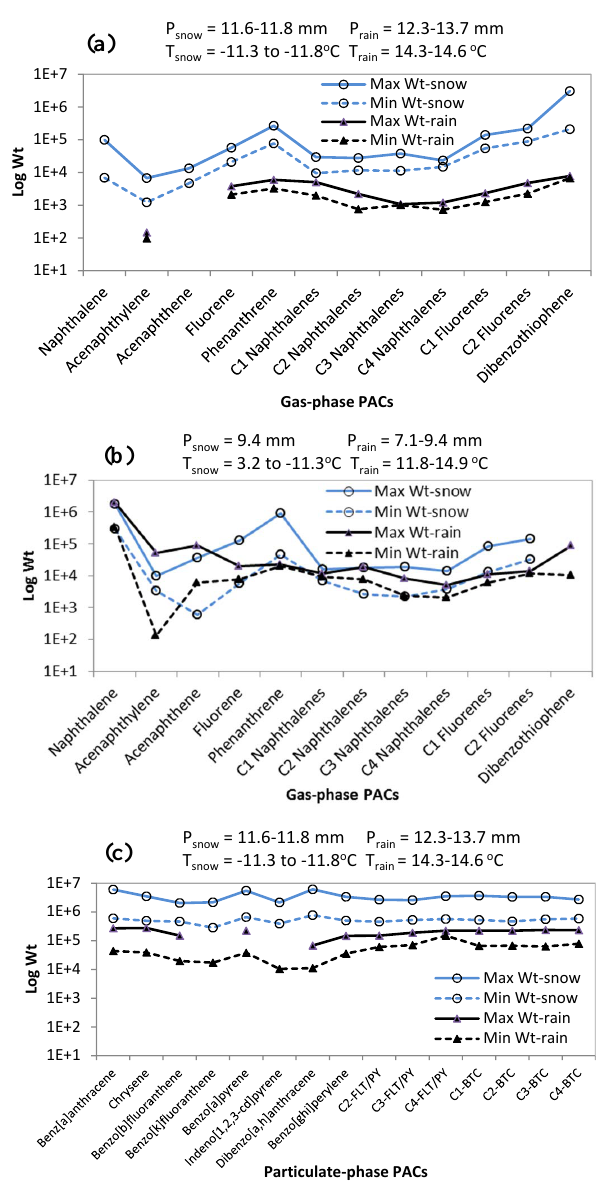
Figure 7. Range of total scavenging ratios ( W t ) in snow and rain samples with (a) similar precipitation rates and air temperatures, (b) similar precipitation rates but different air temperatures, and (c) same as (a) but for particulate PACs. Note the use of the log scale for W t , which indicates that the range of W t for snow is much larger than what is shown on the graph. P = monthly precipitation; T = air temperature. FLT/PY = fluoranthene/pyrene; BTC = benz( a